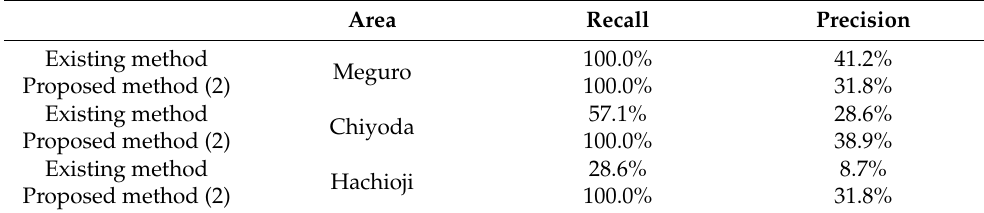
Table 6. For each municipality, the recall rate and precision rate. Area Recall